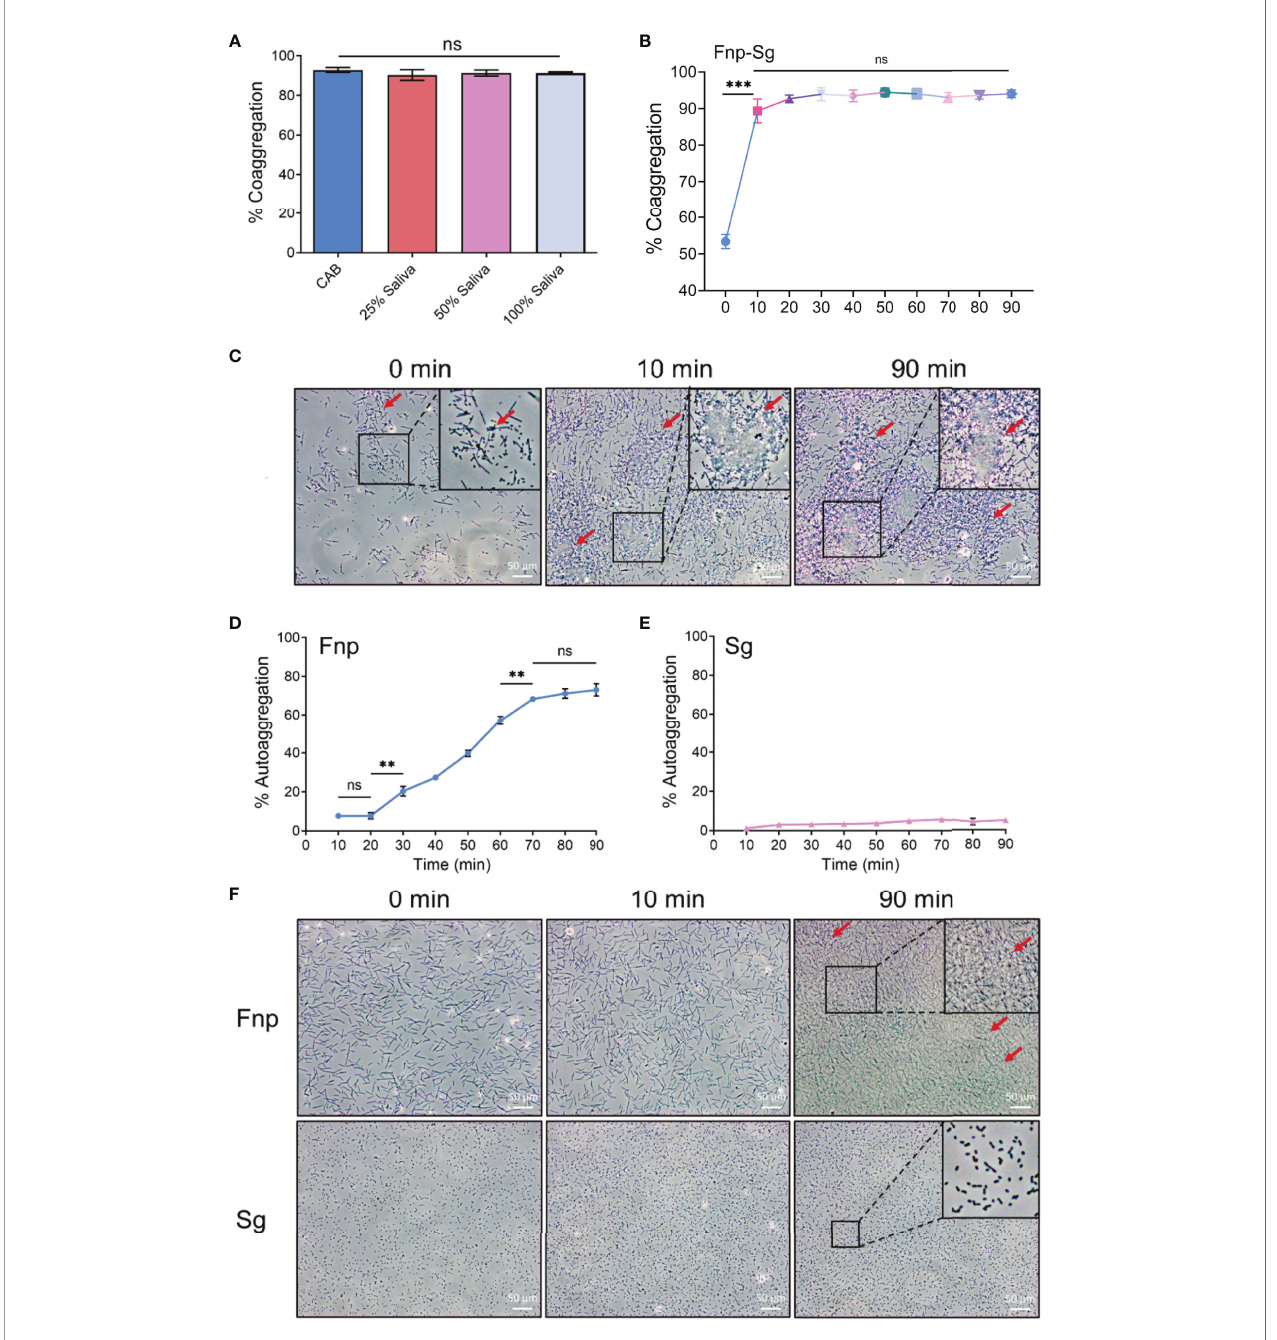
FIGURE 1 | (A) Quantitative coaggregation assays between F . nucleatum subsp. polymorphum and S. gordonii in CAB and different concentrations of arti fi cial saliva. (B) The stability of coaggregation between F . nucleatum subsp. polymorphum and S. gordonii in CAB in 90 min. (C) Phase contrast microscopy images of coaggregation between F . nucleatum subsp. polymorphum and S. gordonii in CAB at 0, 10 and 90 min (red arrows: coaggregates). (D) The autoaggregation of F . nucleatum subsp. polymorphum at 90 min. (E) The autoaggregation of S. gordonii at 90 min. (F) Phase contrast microscopy images of autoaggregation of F . nucleatum subsp. polymorphum and S. gordonii in CAB at 0, 10 and 90 min (red arrows: autoaggregates) ( **p <0.01, ***p <0.001 , ns: not statistically signi fi